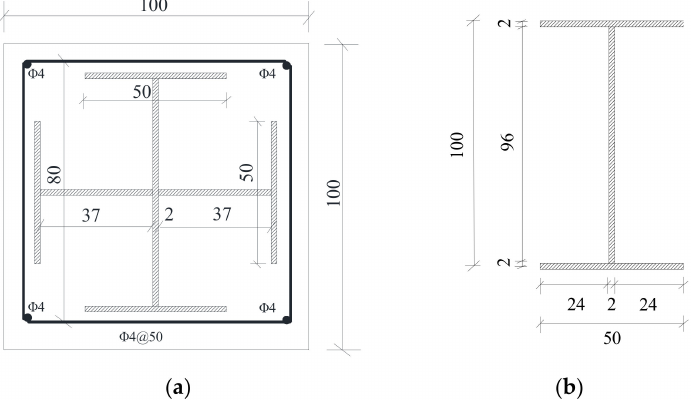
Figure 3. Details of components: ( a ) steel reinforced concrete (SRC) column and ( b ) steel beam. (units: